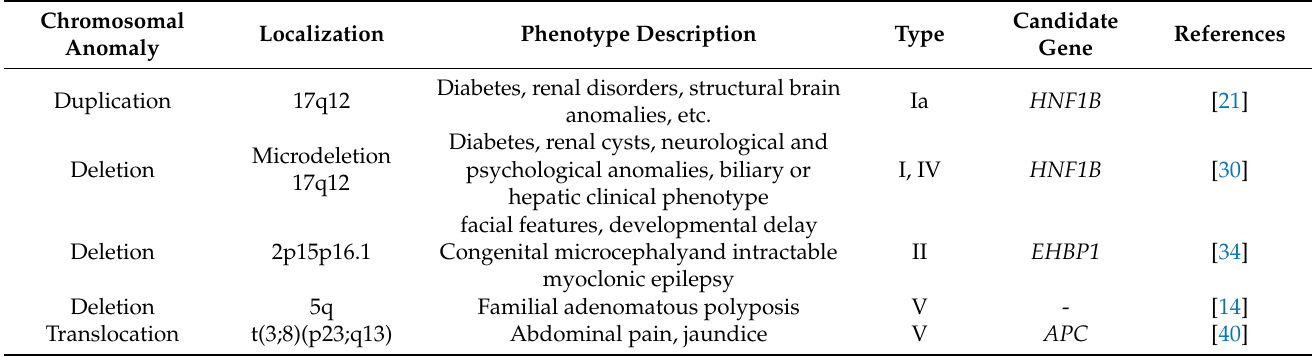
Table 1. Chromosomal alterations reported in choledochal cyst